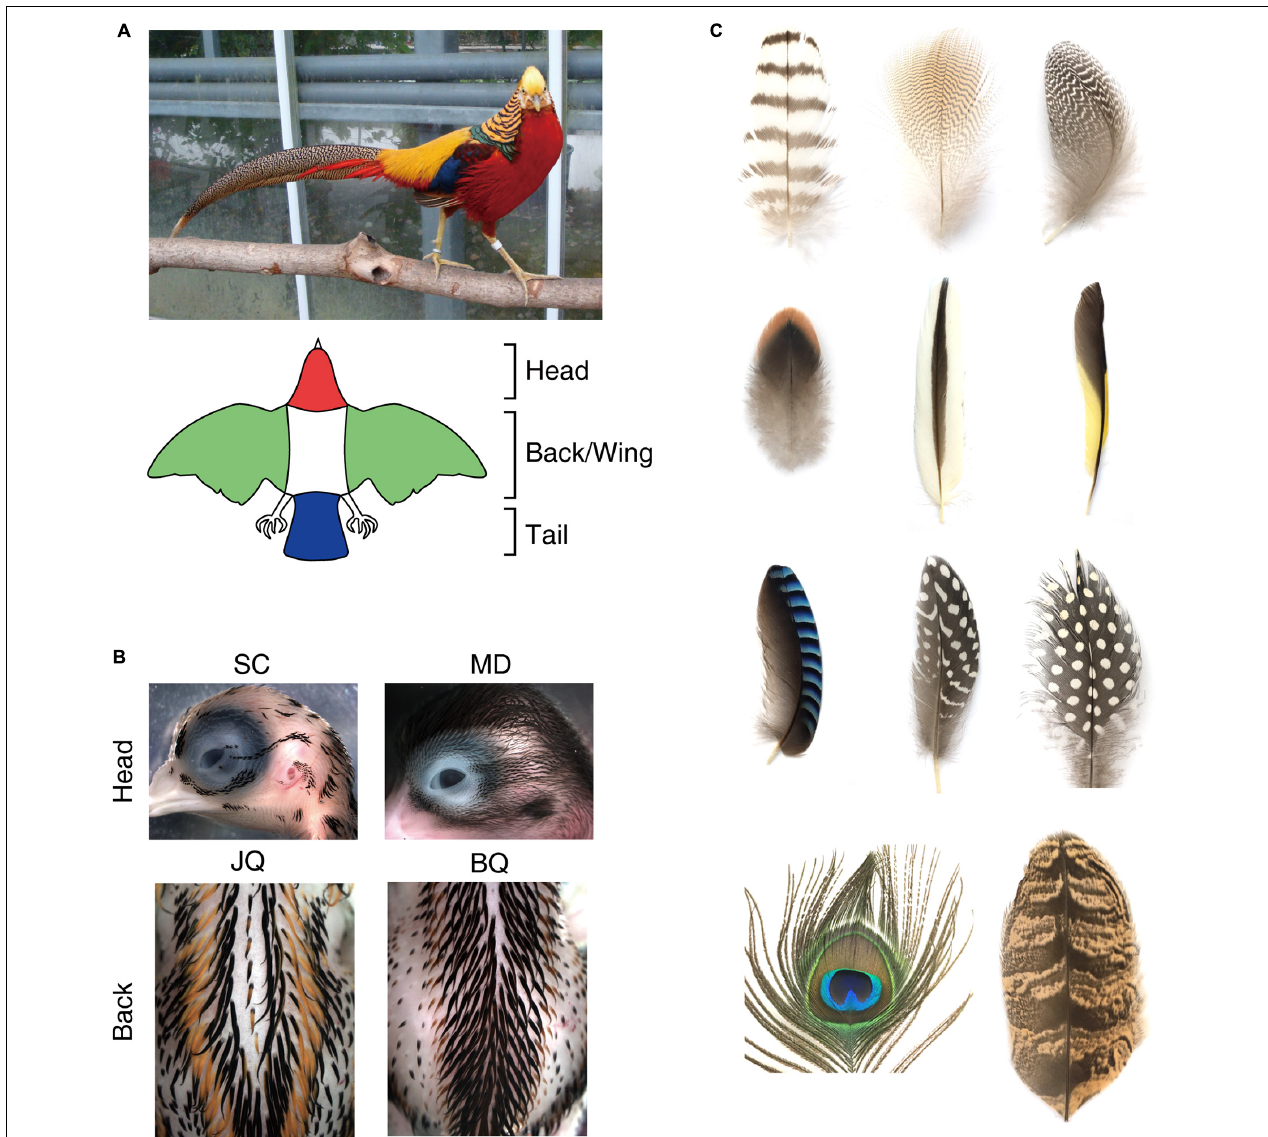
FIGURE 1 | Macro- (across the body or within a skin domain) and micro (within a feather) color patterns in the bird. (A) Color patterns across the whole body. Upper: a male golden pheasant. Lower: a schematic drawing showing a typical whole color pattern in birds. (B) Pigment patterns within domains. Upper: pigment patterns on the head in an E12 Sicilian Buttercup chicken (SC) and E16 Mallard duck (MD). Lower: distinct pigment stripe patterns in E10 Japanese quail (JQ) back skin and E13 Bobwhite quail (BQ). (C) Diversity of pigment patterns within a feather. Photos by M. Inaba.